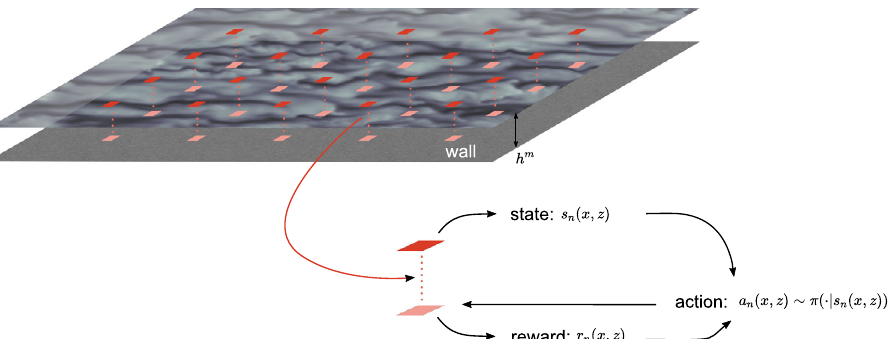
Fig. 1 Diagram of the SciMARL setup. Agents are distributed evenly along the wall, with each agent obtaining state information wall-normal height h m away from the wall, computing the reward at the wall and supplying into the policy π to obtain actions a for the next